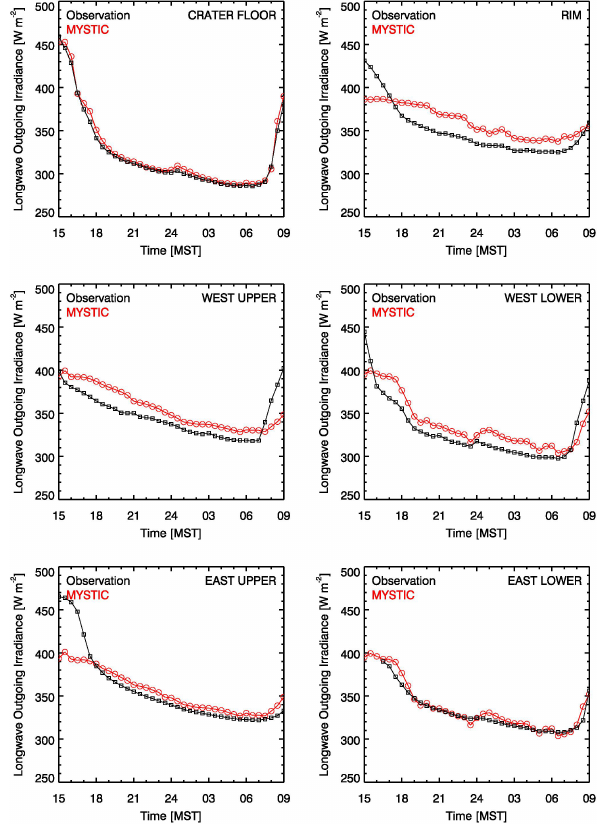
Fig. 9. Observed (black) and modeled (red) slope-parallel longwave incoming radiation at the six crater sites for the night of 22–23 Oc- tober 2006.